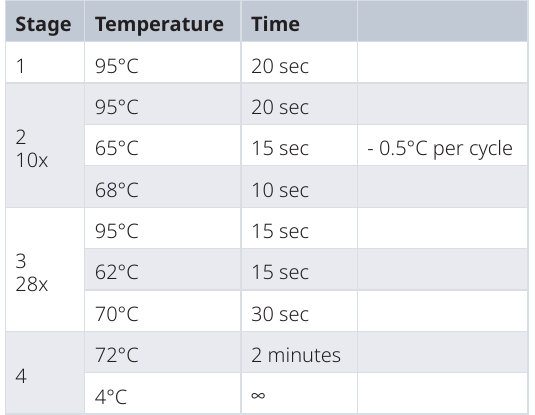
Table 2. PCR reaction conditions.